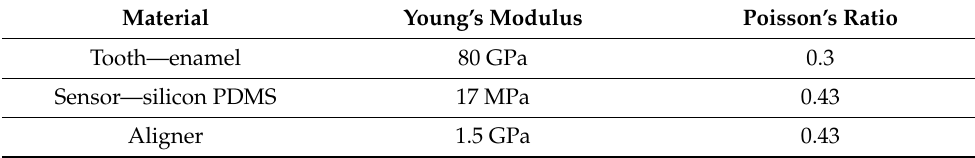
Table 1. Material properties of the finite element model for the aligner sensor.